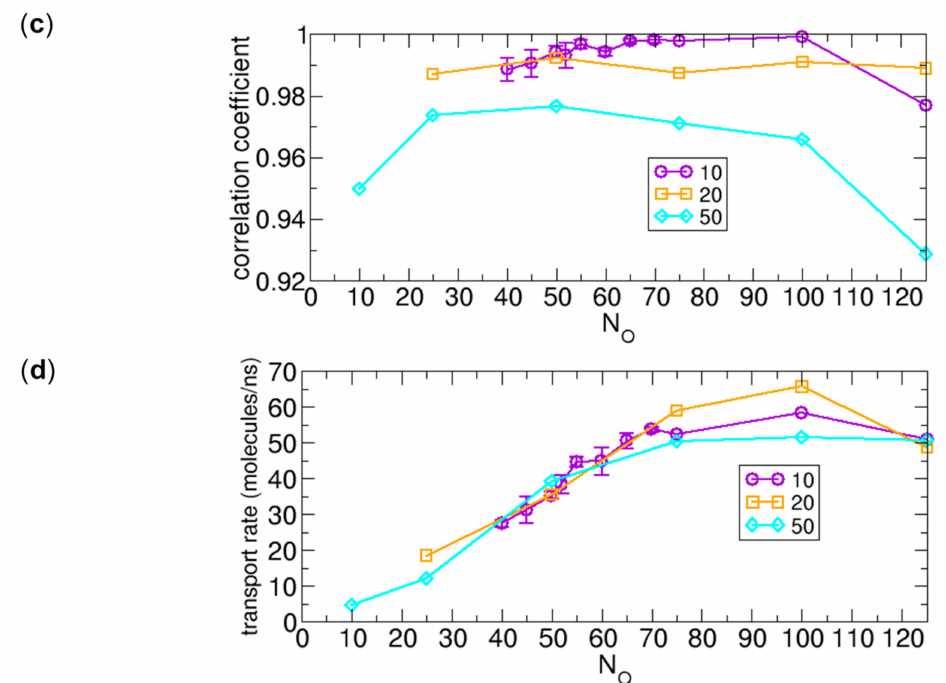
Figure 11. Detailed analysis of water transport observed in Figure 4, Figure 9, and Figure 10. ( a ) Linear curve fitting for the data of N 1 versus time t (ns). The curve fitting is applied only to the water transport region. The resulting linear curve is N 1 = − 52.3 t + 3179.6 and the correlation coe ffi cient is 0.998. The configurations in the insets are provided to show what occurs during water transport. ( b ) Transition time from the initial state to State II or State III due to water transport (or duration of water transport) as functions of the number of osmolytes ( N O ) for IS WO = 10, 20, and 50. ( c ) Correlation coe ffi cient calculated from the linear curve fitting as a function of N O for IS WO = 10, 20, and 50. ( d ) Transport rate obtained from the slopes of the fitted linear curves as a function of N O for IS WO = 10, 20, and 50. When multiple data sets for water transport are available for one system (e.g., N O = 50 and IS WO = 10 in Figures 9 and 10), we calculate the average over the multiple sets and the associated standard deviation and plot them in the